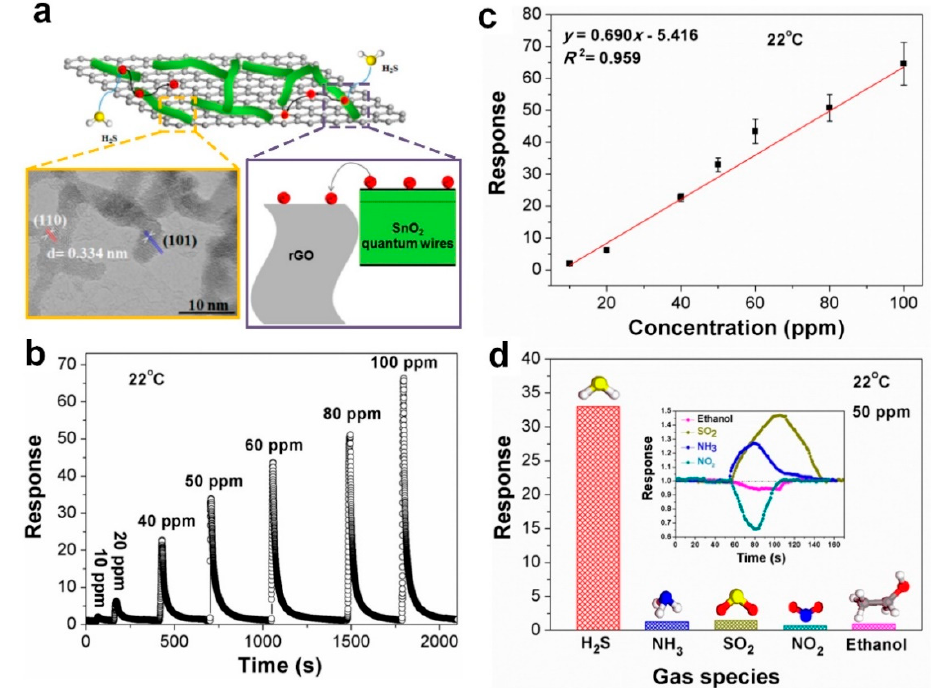
Figure 4. ( a ) Schematic illustration of H 2 S-sensing mechanism of gas sensors employing SnO 2 quantum wire/rGO nanocomposites. High-resolution transmission electron microscopy (HRTEM) image of the pristine SnO 2 quantum wires on rGO nanosheets. ( b ) Sensor response toward H 2 S gas with different concentrations from 10 to 100 ppm. ( c ) Dependence of the response upon gas concentration.